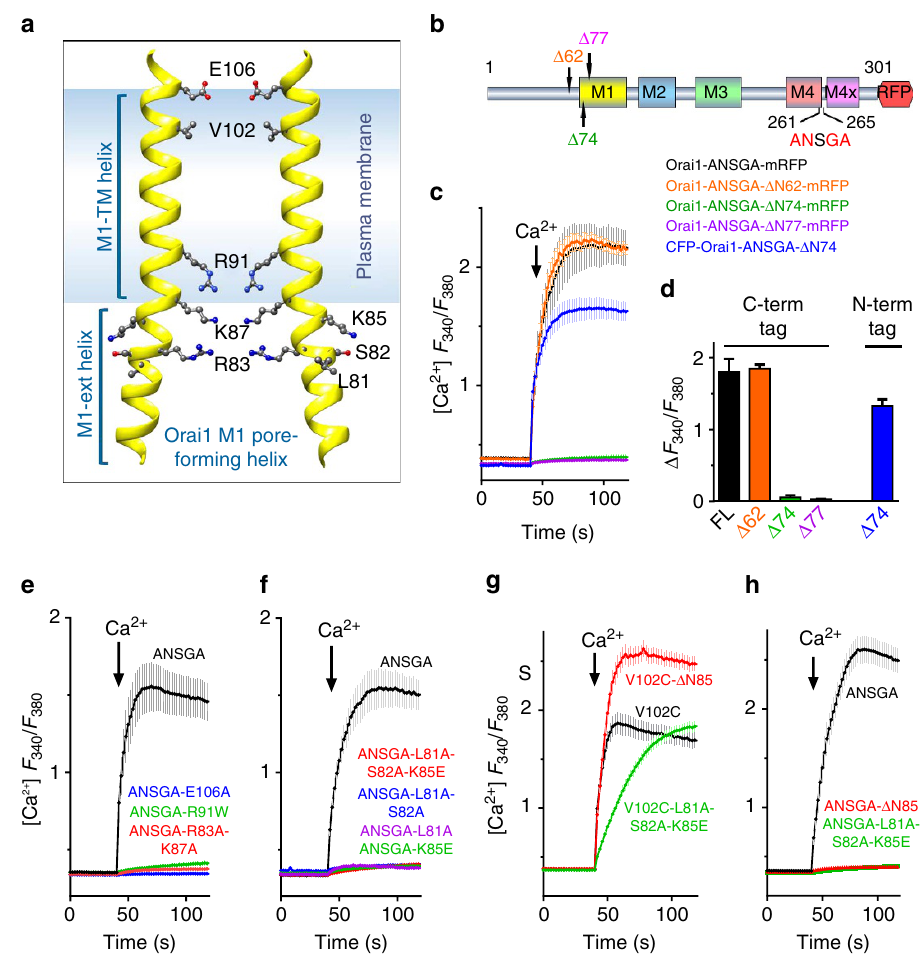
Figure 6 | Disruption of the Orai1 N-terminal M1-ext compromises pore function but is not the STIM1 gating site. ( a ) The pore-forming M1 helices of two opposing subunits of the hexameric Orai1 channel showing key residues to be mutated. ( b ) N-terminal truncations ( D 62, D 74 and D 77) of Orai1- ANSGA-mRFP. ( c ) Constitutive fura-2 Ca 2 þ responses in HEK cells expressing Orai1-ANSGA-mRFP (black), Orai1-ANSGA- D N62-mRFP (orange), Orai1- ANSGA- D N74-mRFP (green), Orai1-ANSGA- D N77-mRFP (purple) or CFP-Orai1-ANSGA- D N74 (blue). ( d ) Summary of the peak Ca 2 þ entry in c . ( e – h ) Constitutive fura-2 Ca 2 þ entry responses in store-replete HEK cells expressing the Orai1 mutants shown: ( e ) key Orai1-M1 pore-lining mutations in CFP-Orai1-ANSGA; ( f ) purported STIM1-binding Orai1-M1-ext outward-facing mutations in CFP-Orai1-ANSGA; ( g ) Orai1-M1-ext mutations or D 1–85 truncation in CFP-Orai1-V102C; ( h ) Orai1-M1-ext mutations or D 1–85 truncation in CFP-Orai1-ANSGA. All values are mean ±